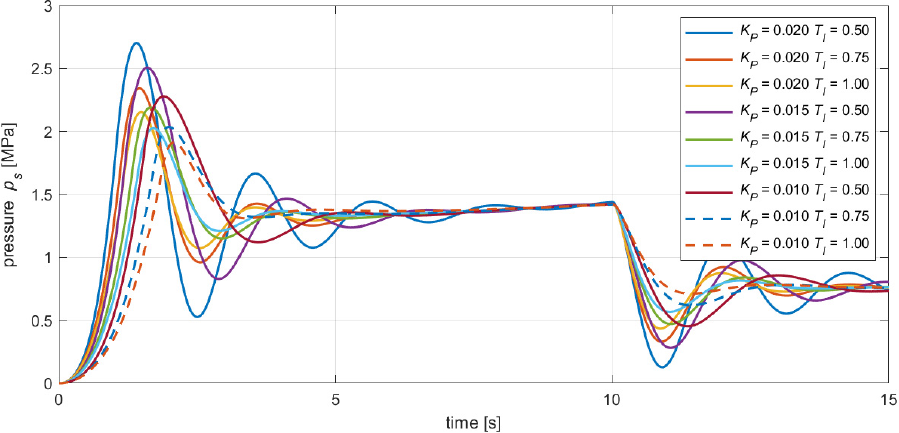
Figure 10. Result of simulation of the waveform of pressure on the motor p s for various parameters of the PI controller.